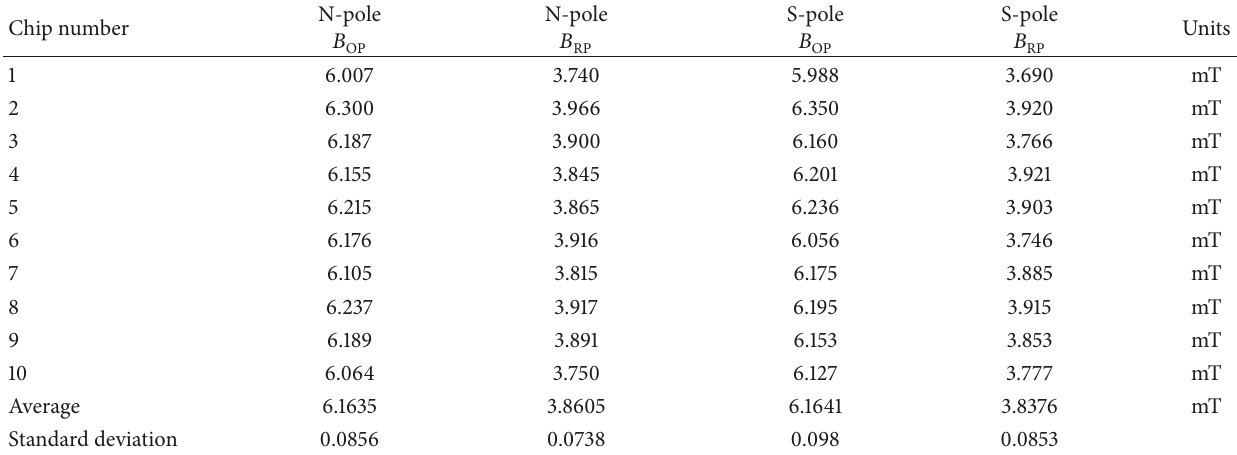
Table 1: Operate points and release points of the Hall switch sensor.